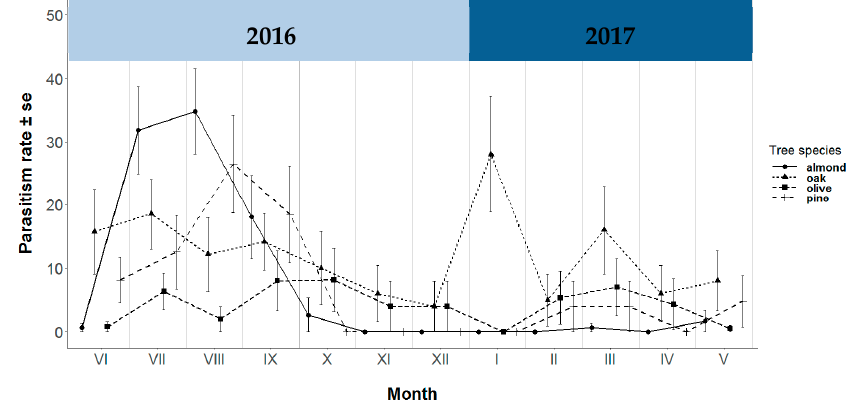
Figure 2. Temporal evolution of parasitism rate (%) in almond, oak, olive and pine trees by month sampled.